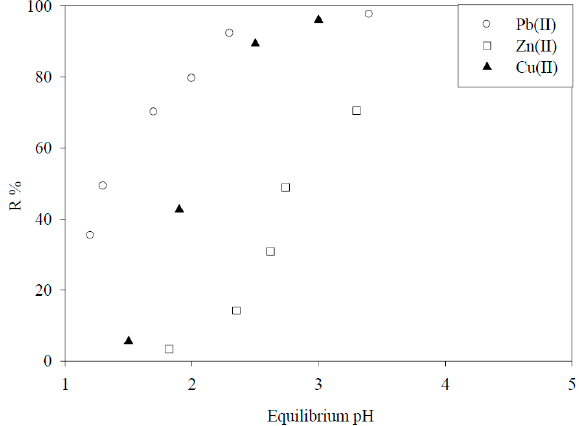
Figure 6. Adsorption of Pb(II), Zn(II), and Cu(II) by crosslinked pectic acid as a function of the equilibrium pH [9]. (With permission for reuse from Elsevier B.V.).